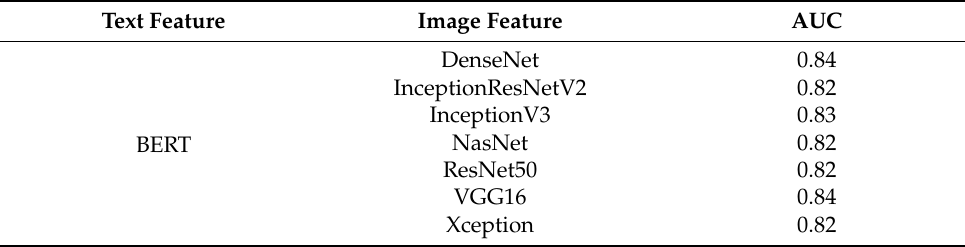
Table 8. AUC comparison for each image